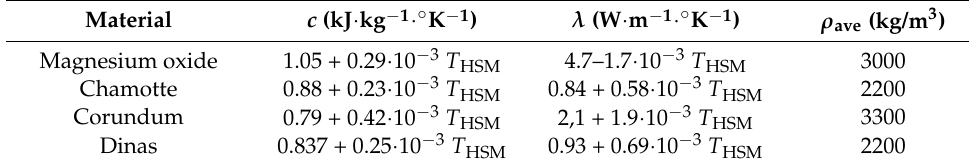
Table 2. Thermal-physical properties of solid-state